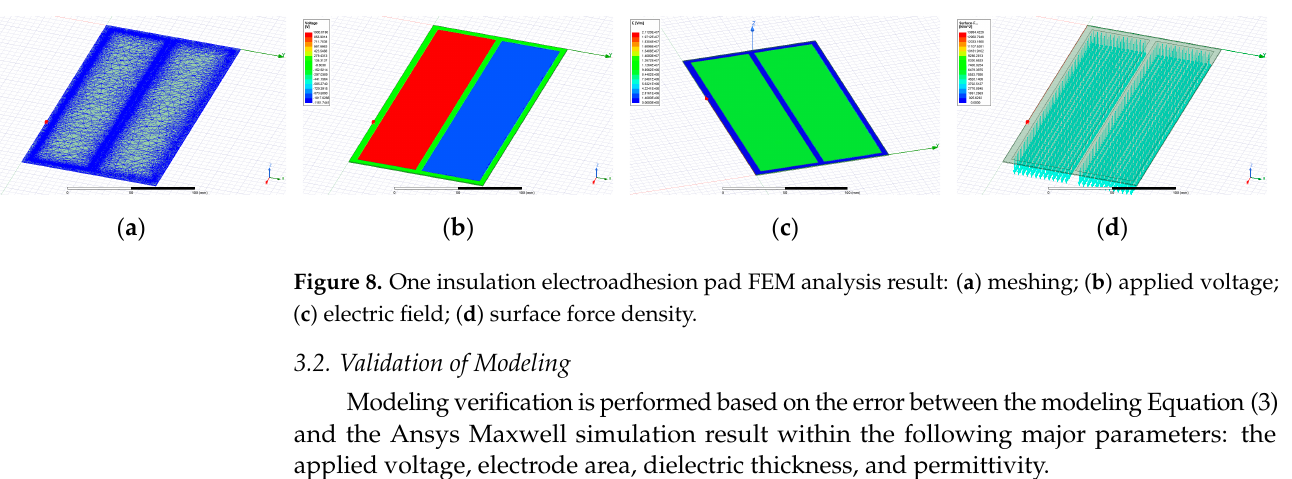
Figure 9. Dual insulation electroadhesion pad FEM analysis result: ( a ) meshing; ( b ) applied voltage; ( c ) electric field; ( d ) surface force density.